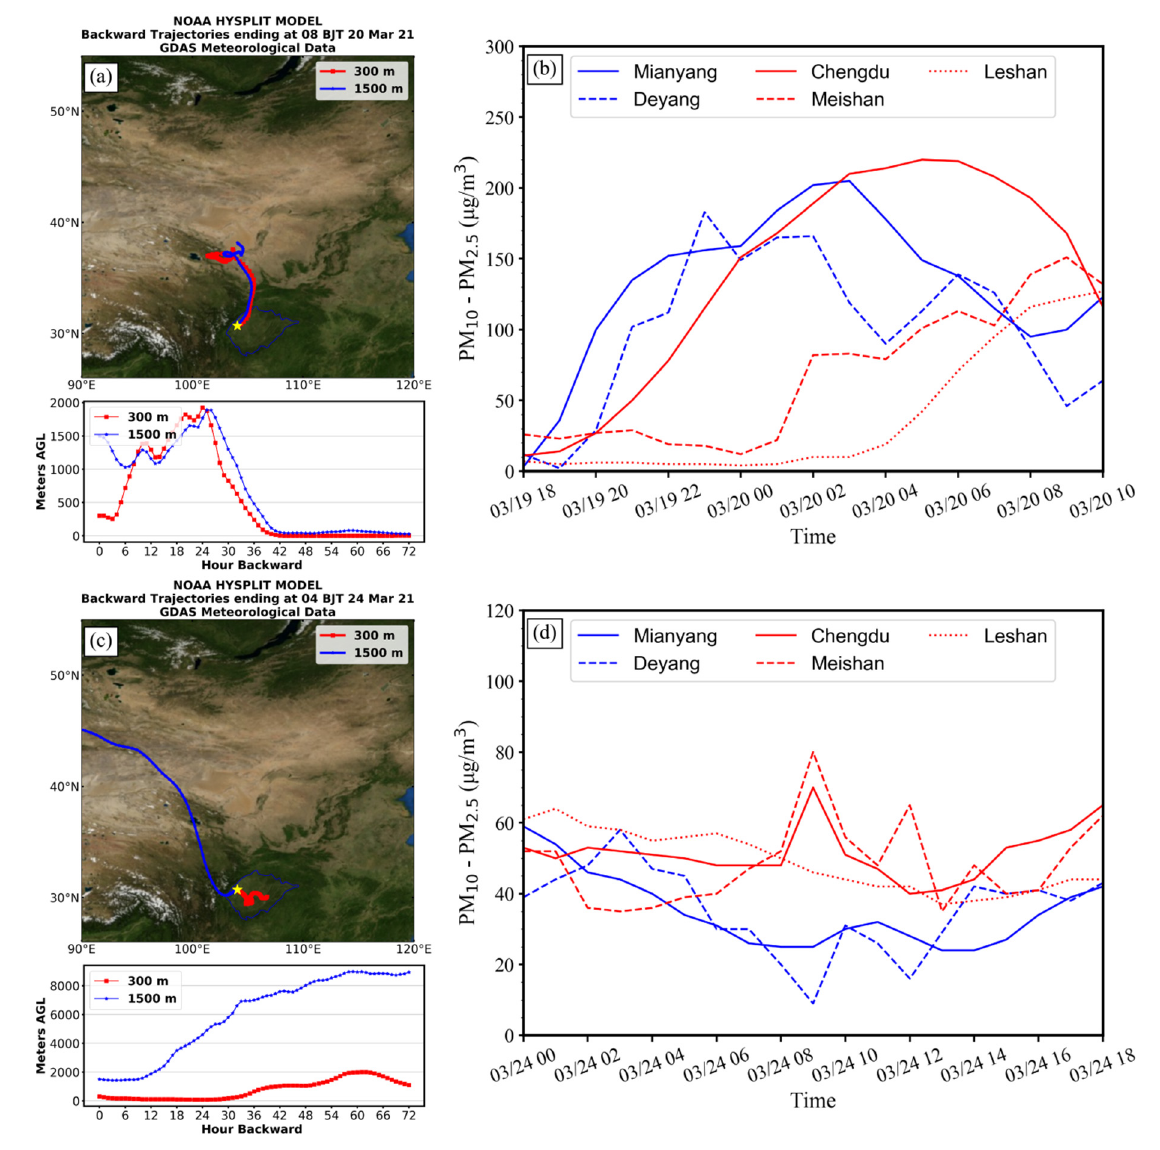
Figure 2. The 72-h backward trajectories starting at 300 m and 1500 m above ground level at 08:00 on 20 March 2021 ( a ) and 04:00 on 24 March 2021 ( c ) in Chengdu, and the concentrations of coarse particles (PM 10 − PM 2 . 5 ) in Chengdu during 18:00 on 19 March and 10:00 on 20 March 2021 ( b ) and during 00:00 and 18:00 on 24 March ( d ).